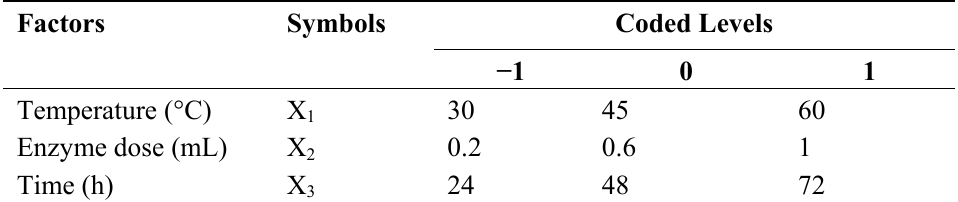
Table 2. Levels of factors chosen for the experimental design of saccharification.